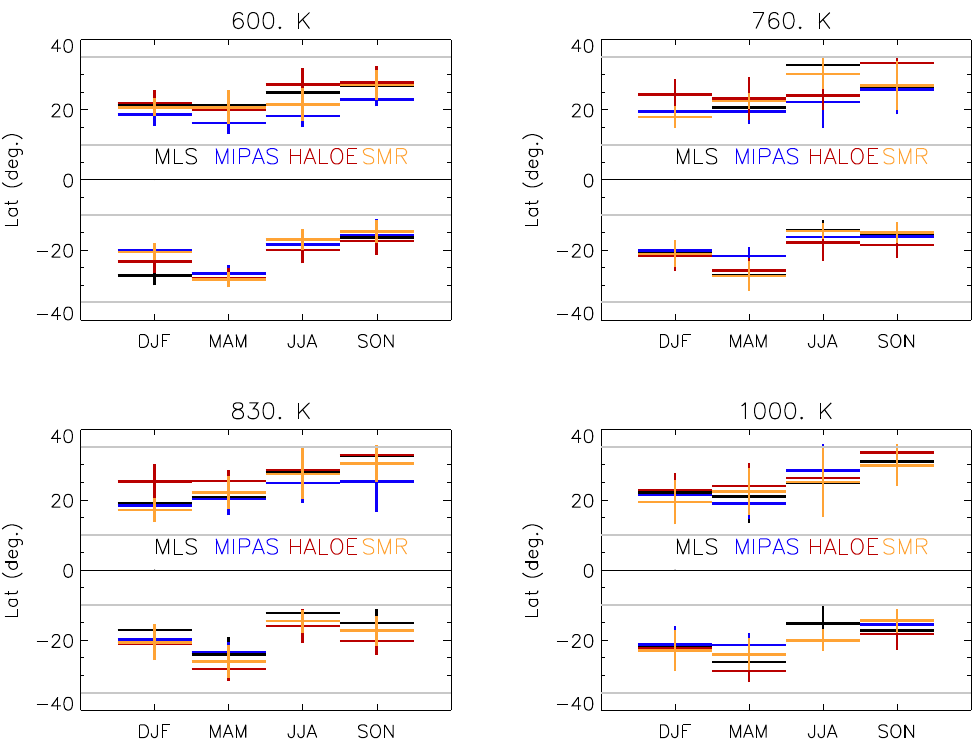
Fig. 6. Annual cycle of the subtropical barrier position (one value for each season) for the MLS (black), MIPAS (blue), SMR (yellow), and HALOE (red) instruments at 600K, 760K, 830K, and 1000K. The figure shows the average over all years available for each sensor, also averaged over the various QBO phases. The horizontal grey lines define the latitude region between 10 and 35 degrees in both hemispheres.